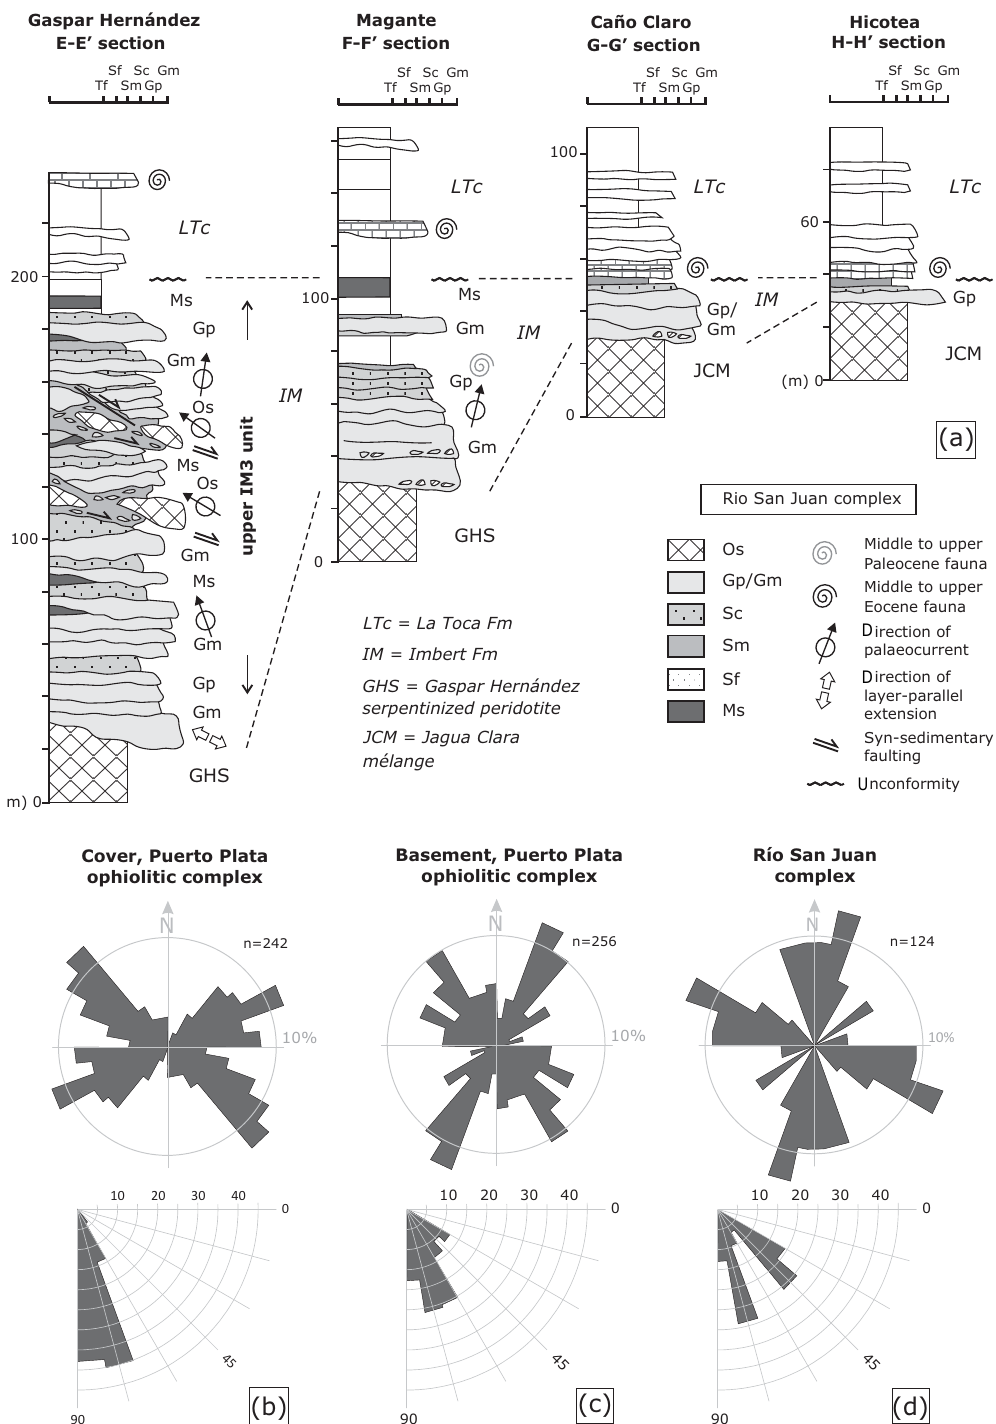
Figure 4. (a) Stratigraphic sections of the Imbert Fm in the Río San Juan complex. Facies assemblages as in Fig. 3, except Os which is composed by lensoidal serpentinite blocks in a heterogeneous and mostly deformed matrix composed of shale, mudstone and sandstone. See text and Supplementary Material A for details and Fig. 2 for location. Trend and dip data of syn-sedimentary joints and small faults affecting (b) the Imbert Fm in the Puerto Plata complex, (c) its ophiolitic basement, and (d) the Imbert Fm in the Río san Juan complex.